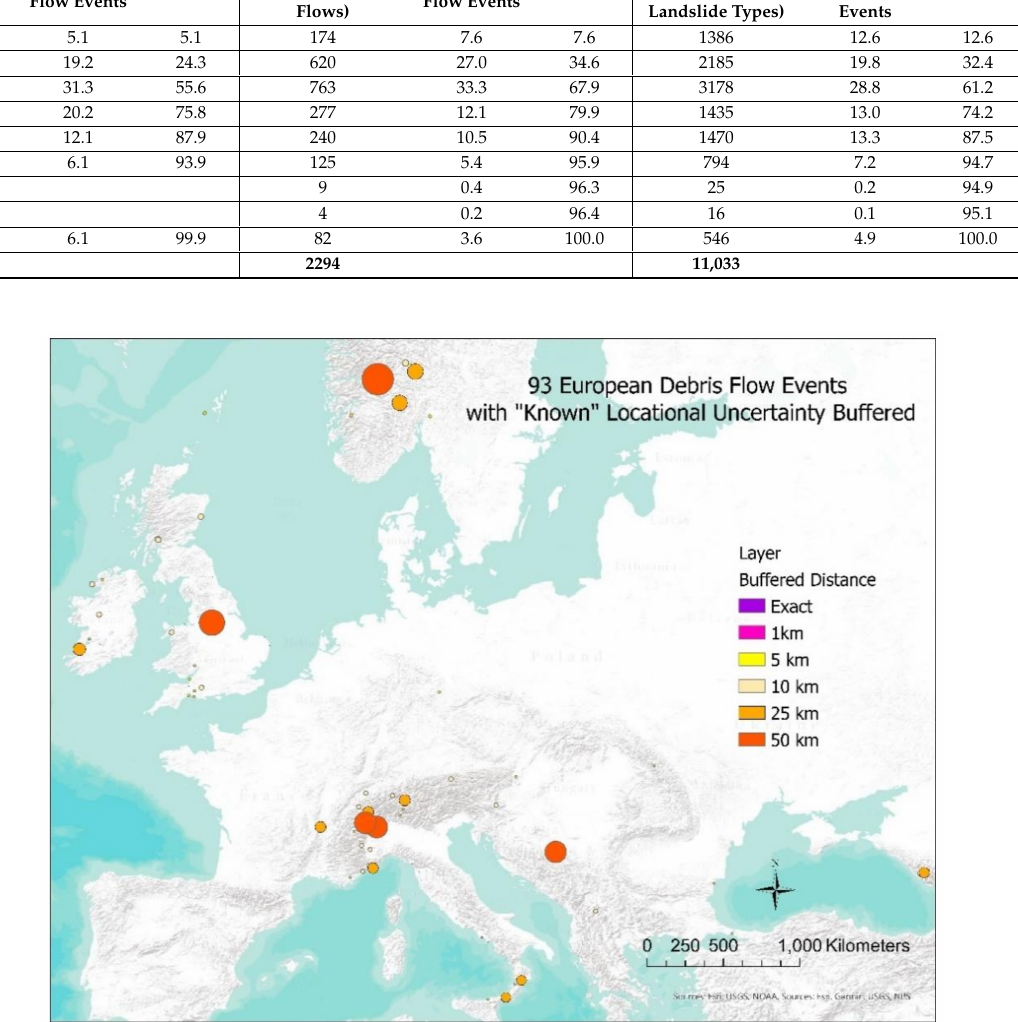
Figure 1. 93 (of 99) European debris flow events with a buffered “known” locational uncertainty. Some larger buffers overlap and occlude nearby smaller buffers. Base map is from ArcGIS ® ,